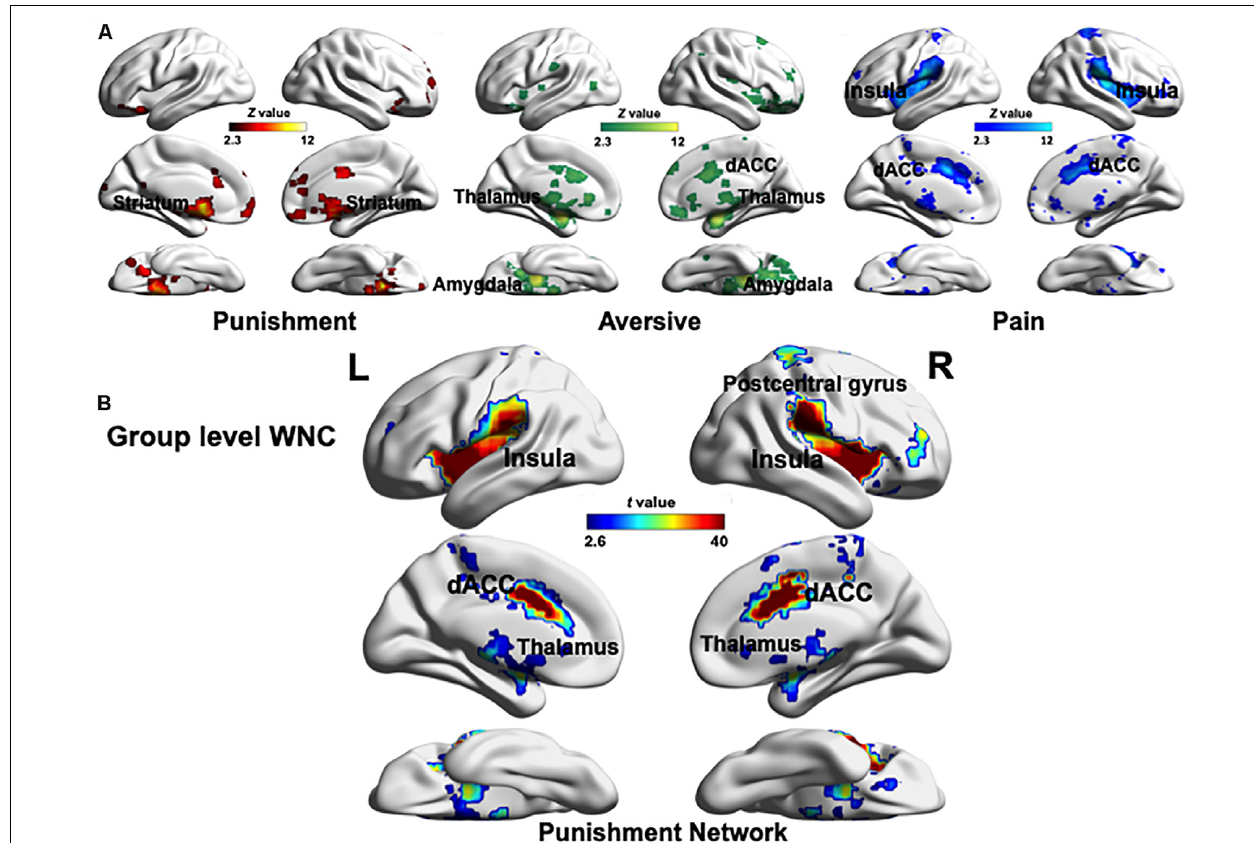
FIGURE 1 | (A) Maps resulting from automatized large-scale meta-analyses as implemented in Neurosynth. Three association test maps displaying brain regions preferentially related to the key terms “punishment,” “aversive,” and “pain” created in the Neurosynth meta-analysis ( Z > 2.3, uncorrected). These three maps involve both similar (the dACC) and specific (notably the striatum, thalamus, amygdala, and insula) brain regions. (B) Global pattern of within-network connectivity (WNC) in the punishment network (PN; combing aforementioned “punishment,” “aversive,” and “pain” maps). The group-level (one-sample t -test) WNC map is overlaid on the cortical surface (FDR corrected p < 0.01). L, left; R, right. The visualization was provided by BrainNet Viewer